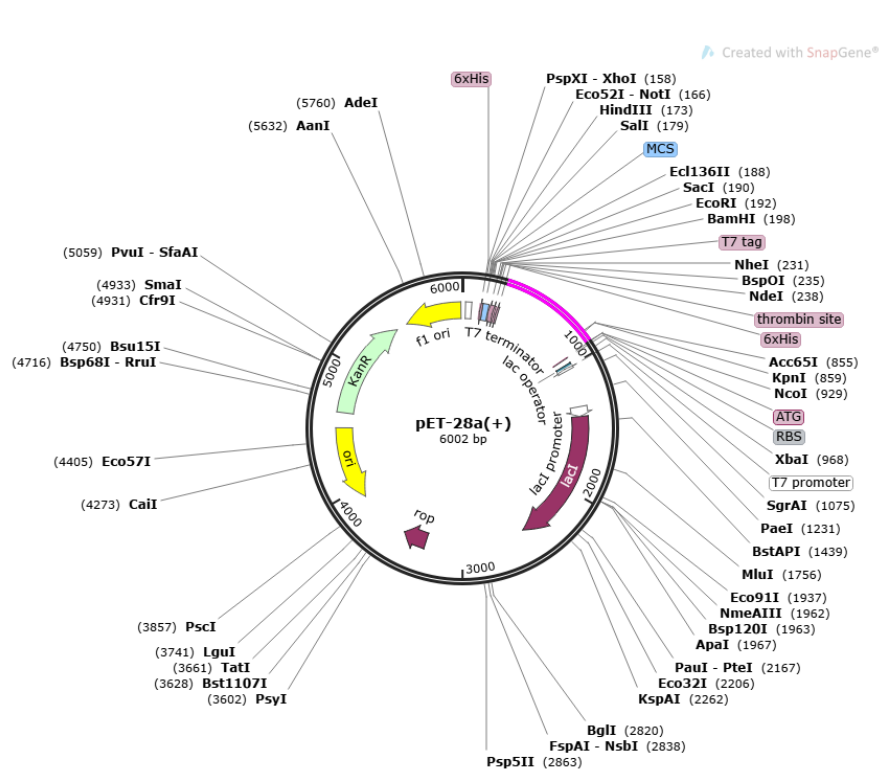
Figure 8. Cloned pET-28a(+) vector. The magenta color represents inserted DNA sequence .